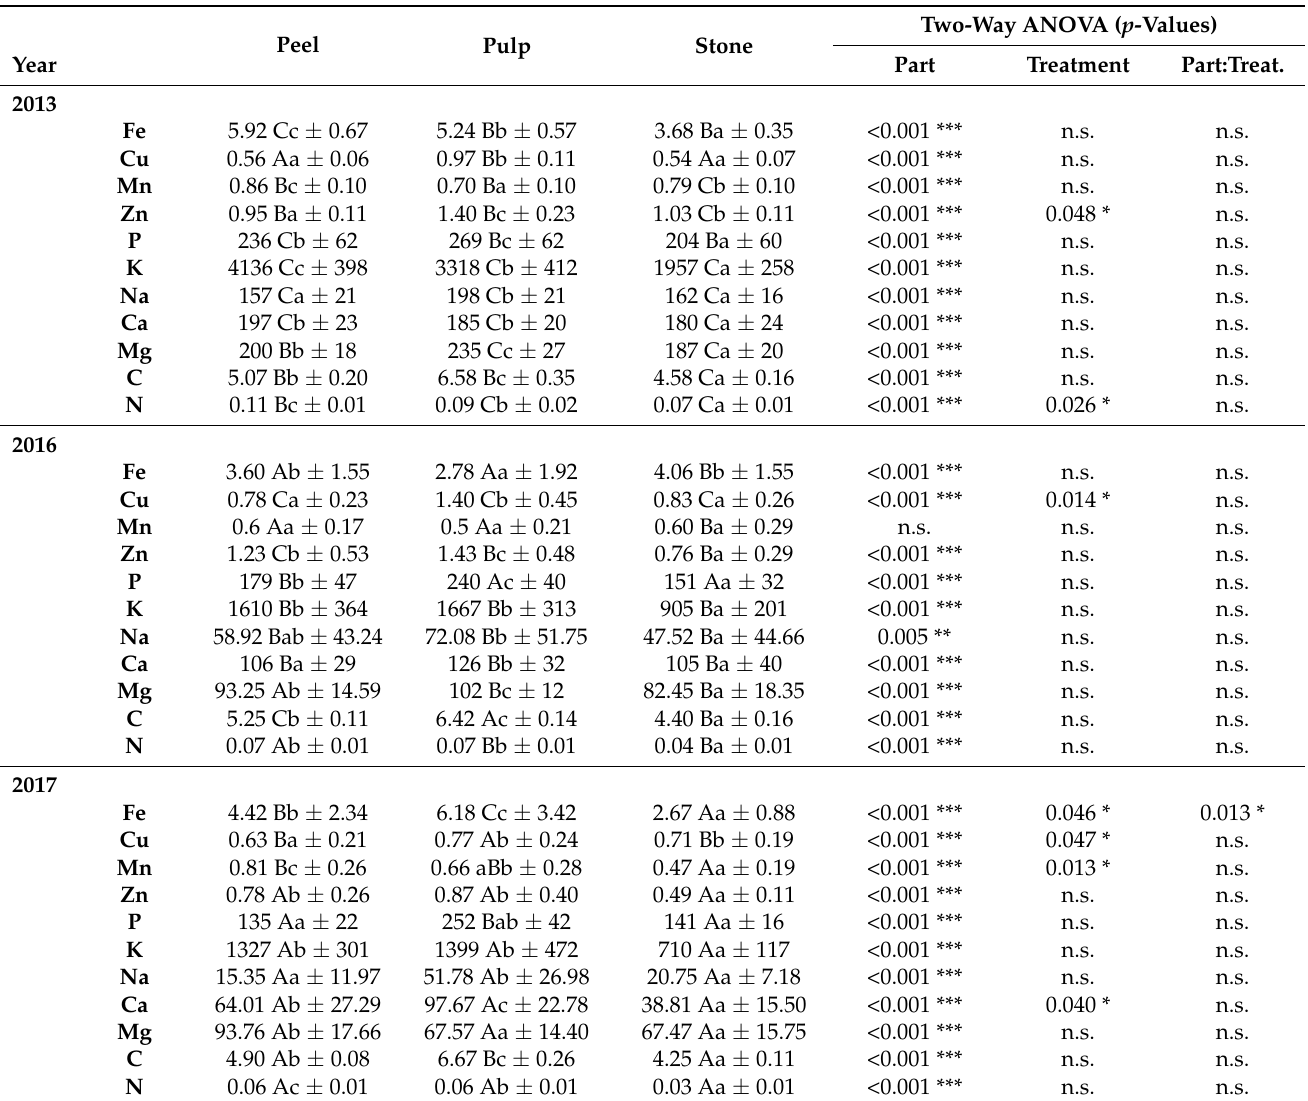
Table 1. Distribution of the nutrient content (mean values and standard deviation) in mg per 100 g of fruit (DM, dry matter) and in g per 100 g for C and N (DM) in each of the three sampling years (2013, 2016, and 2017) for the three parts of the avocado fruit (peel, pulp, and stone). Lowercase letters indicate for each nutrient individually the differences among the fruit parts (peel vs. pulp vs. stone) per each year separately, and uppercase letters indicate for each nutrient the significant differences among the years of study (2013 vs. 2016 vs. 2017) for the same part of the fruit separately (post-hoc Tukey’s test p < 0.05). Two-way ANOVA p -values for the part of the fruit and the treatments applied are shown at * p < 0.05, ** p < 0.01, and *** p < 0.001; n.s. means not significant at p < 0.05. Two-Way ANOVA ( p -Values) Peel Pulp Stone Part Treatment